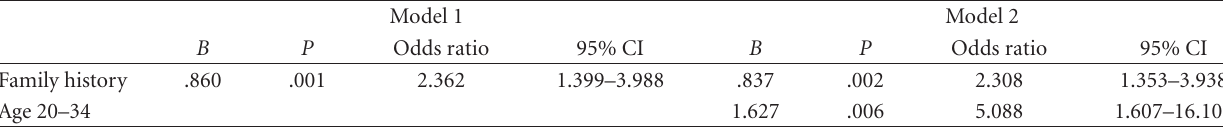
Table 4: Final logistic regression model for receiving genetic counseling and risk assessment.